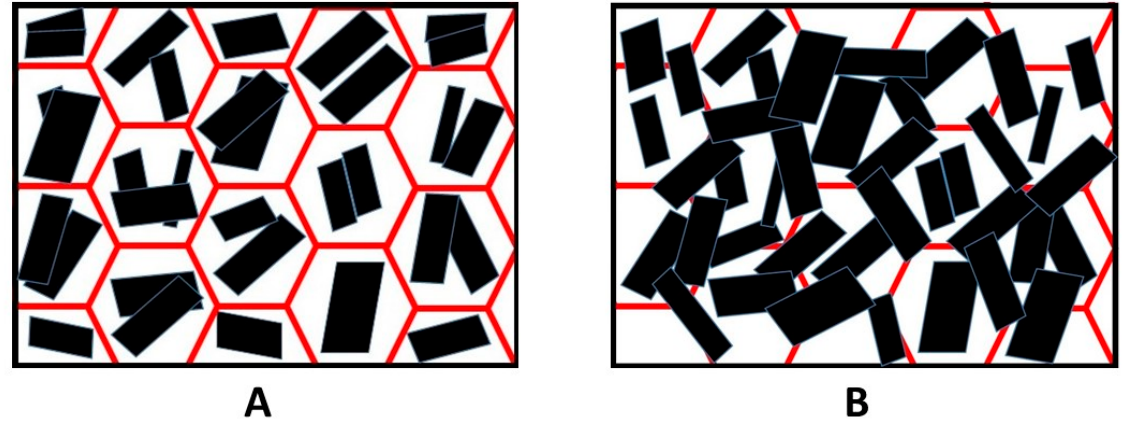
Figure 11. The scheme of surface of coated sample ( A ) and heat-treated coated sample ( B ).